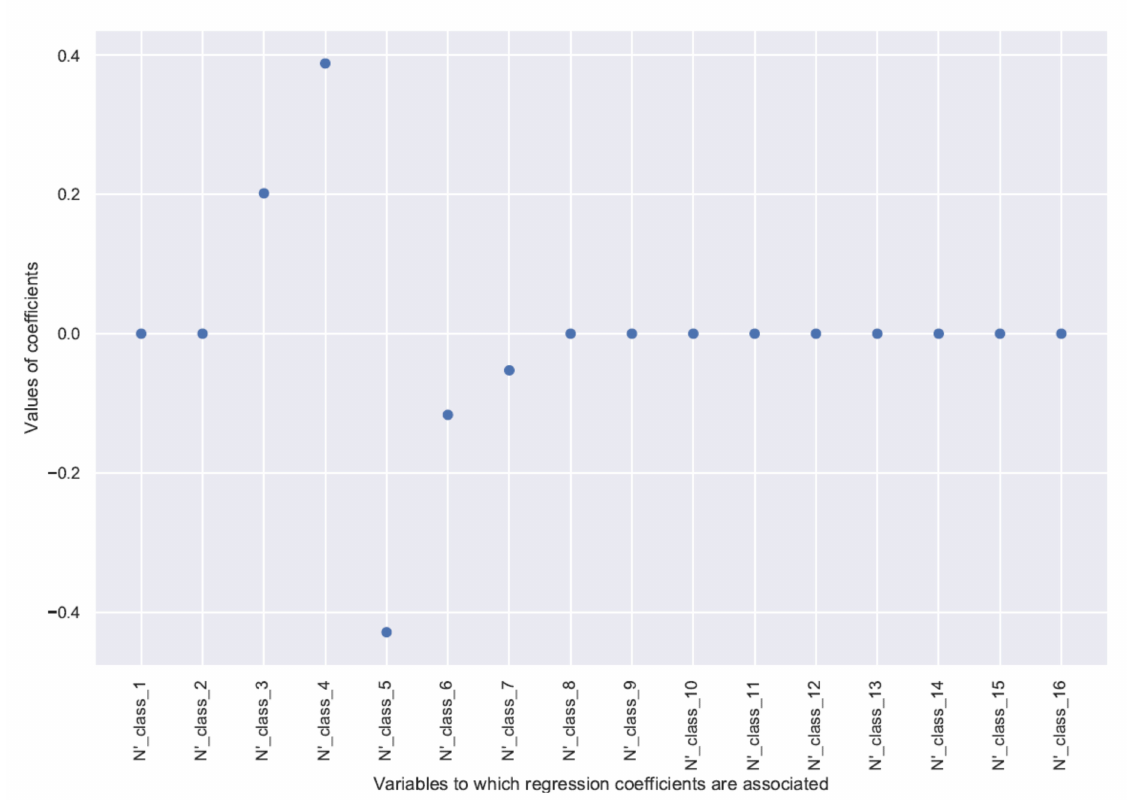
Figure 4. Regression coefficients for the model of diameter class 5, associated with transformed features N (cid:48) d